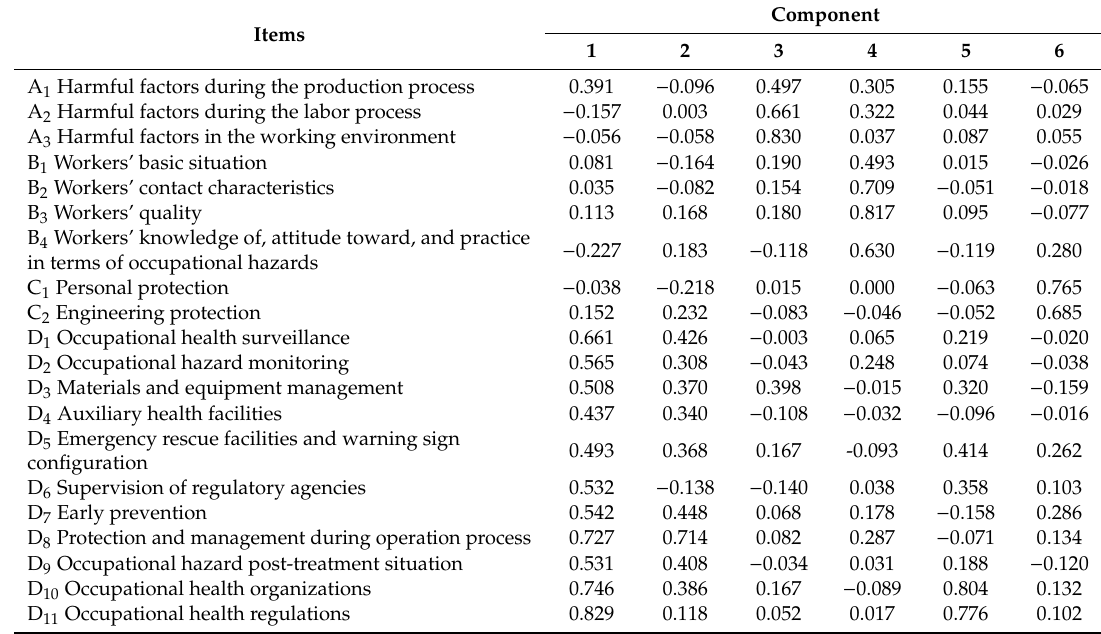
Table 7. Component matrix rotated by